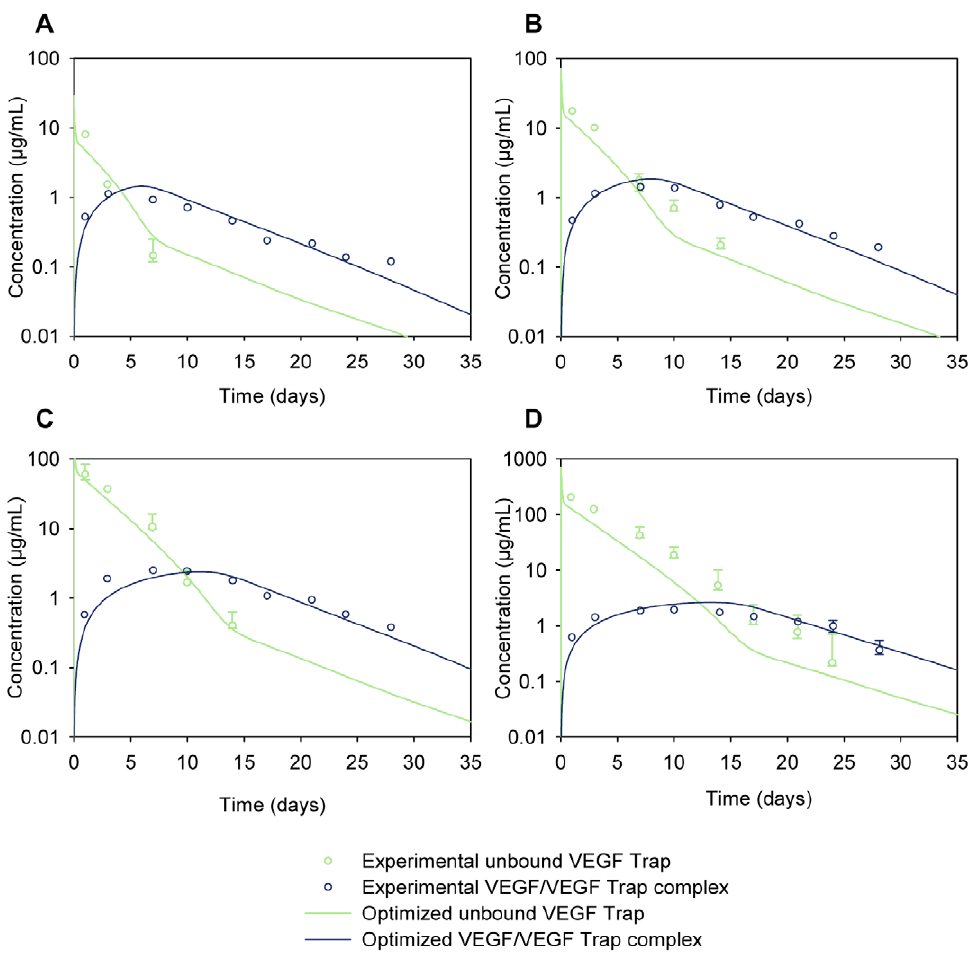
Figure 3. Parameter optimization. Model parameters were optimized computationally to fit simulation results (solid lines) to experimental data (open circles) [16] for the concentration profiles of the unbound VEGF Trap and the VEGF/VEGF Trap complex. VEGF Trap was injected intravenously (into the blood compartment) at (A) 1 mg/kg, (B) 2.5 mg/kg, (C) 10 mg/kg, and (D) 25 mg/kg. tion approach that explored the free parameter space and returned the combination of free parameter values that allowed the simulation results to best fit the experimental data from Rudge et. al [16] (Figure 3, open circles). The parameter optimization was performed using MATLAB H , which solves the non-linear least squares problem and uses the trust-region- reflective optimization algorithm [66,67]. The objective func- tion that was minimized was the weighted sum of squared residuals (WSSR) and obeyed: